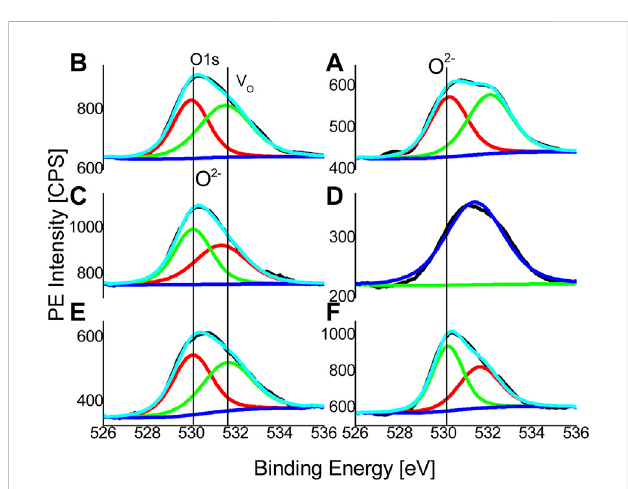
FIGURE 6 The XPS spectra for oxygen-1 s electrons are displayed together with a Gaussian component that has been fi tted for oxygen vacancies andtheanionicsub-latticeofZnO,respectively.Metal-oxideandoxygen vacancy states, respectively, are indicated by the vertical lines at ~530 and ~532 eV (A – F)